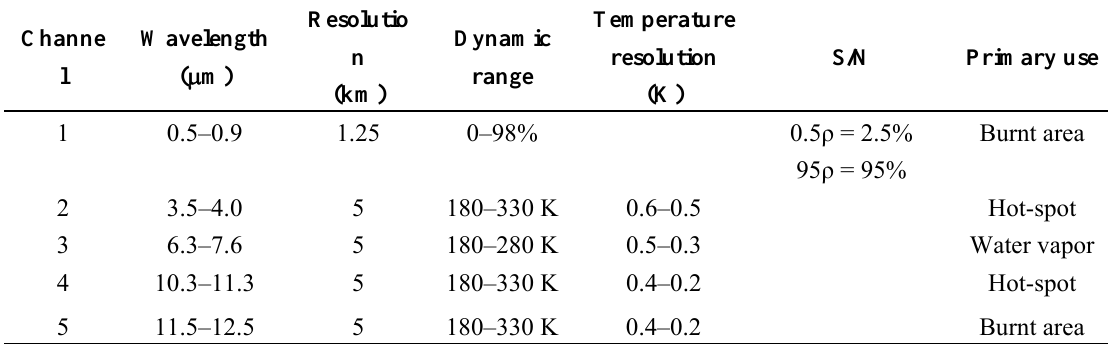
Table 2. The channel characteristics of VISSR onboard FY-2C/2D satellites.